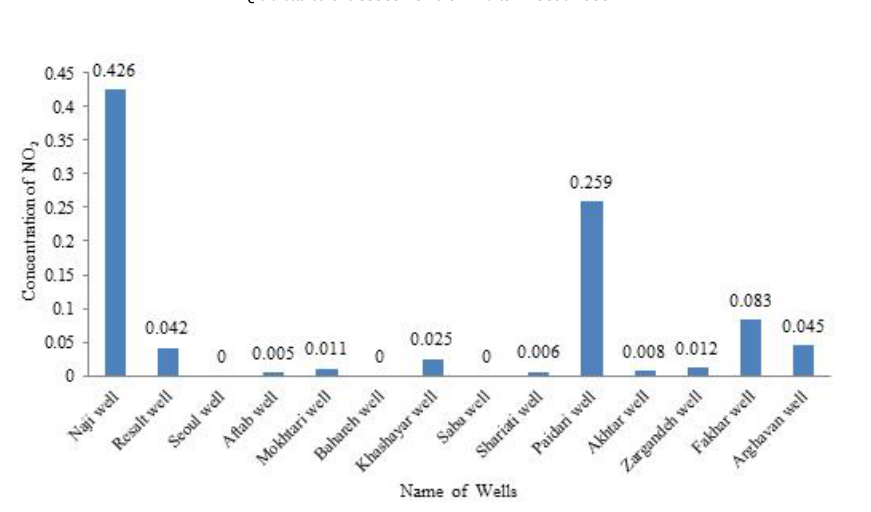
Fig. 8: Comparison of NO2 value in the stations